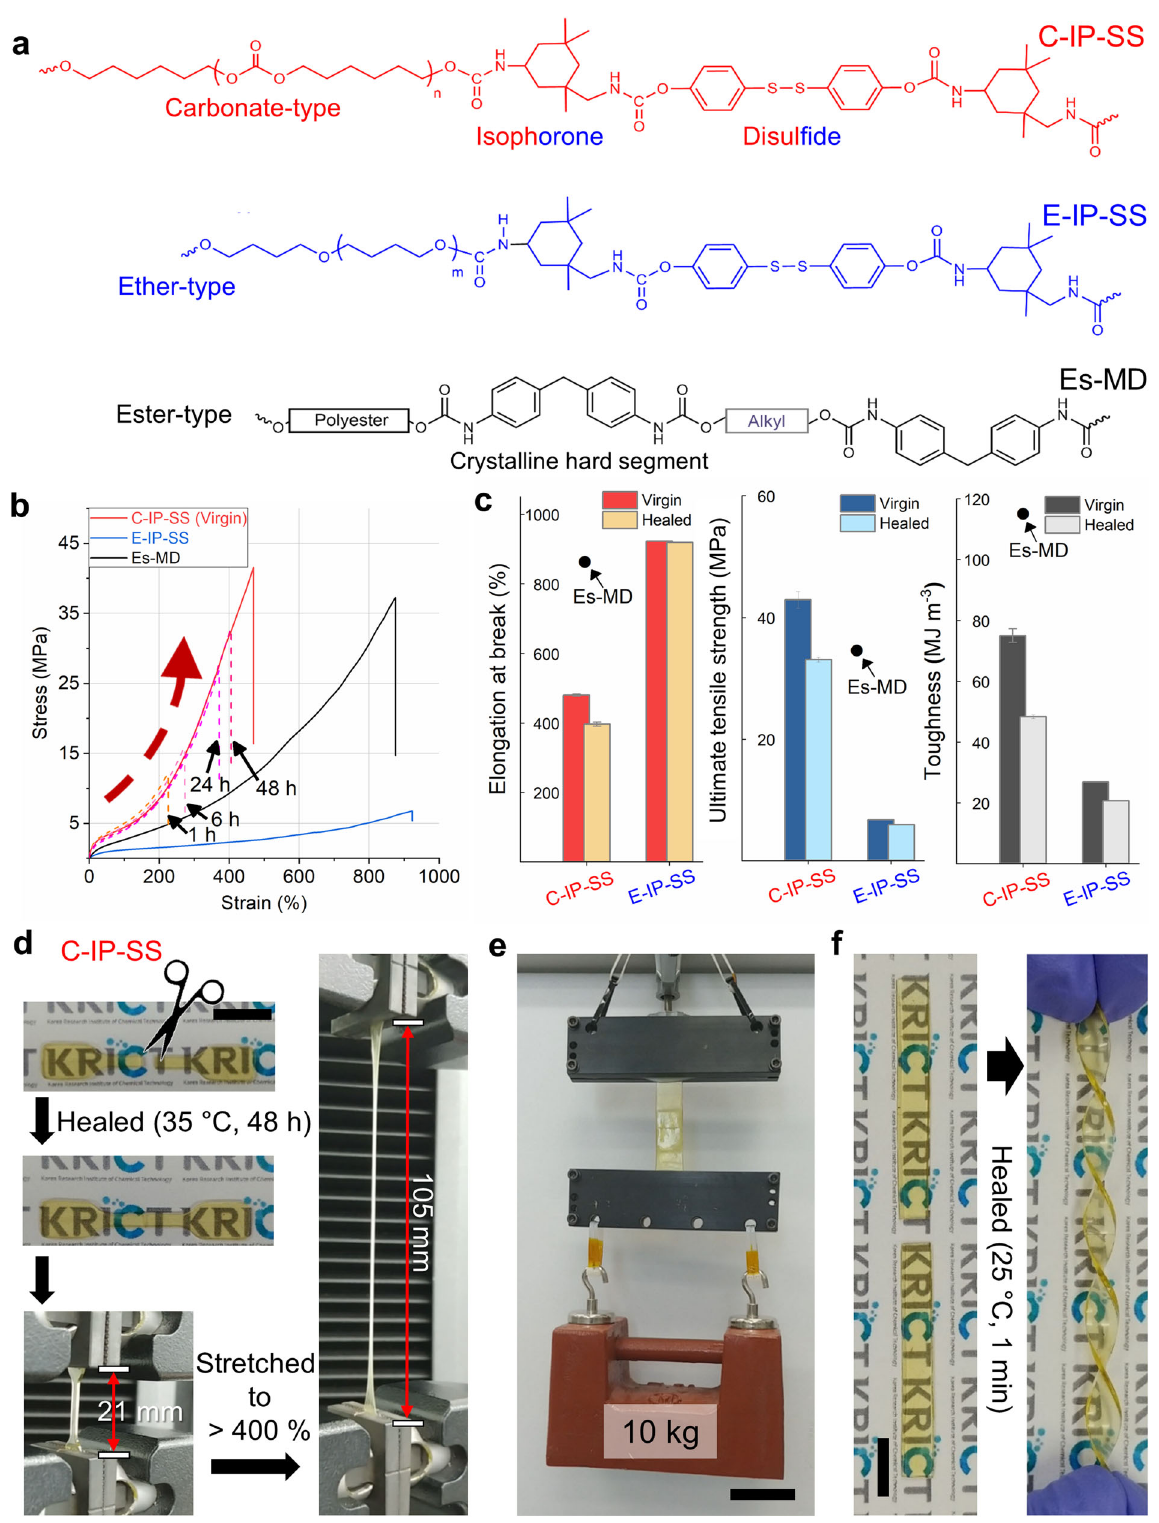
Fig. 1 Chemical structures and mechanical properties of self-healable TPUs. a Chemical structures and b tensile stress – strain curves for the three TPUs: C-IP-SS, E-IP-SS, and commercial Es-MD. Tensile curves of cut and rejoined C-IP-SS with different healing times at 35 °C are included. c Comparing mechanical properties, such as elongation at break, ultimate tensile strength, and toughness, for virgin and healed TPUs. The value for the non-self-healable Es-MD is given as a point in each panel. d Photographic images of cut and healed C-IP-SS fi lms before (left) and after stretching up to 400% (right) (scale bar: 1 cm). e C-IP-SS fi lm (thickness: 0.3 cm) cut in half, rejoined, and healed for 48 h at 35 °C, followed by a 10-kg weight-lifting demonstration (scale bar: 5 cm). f Photographic images of a twisted C-IP-SS fi lm (thickness: 0.1 cm) after healing at 25 °C for 1 min (scale bar: 1 cm).